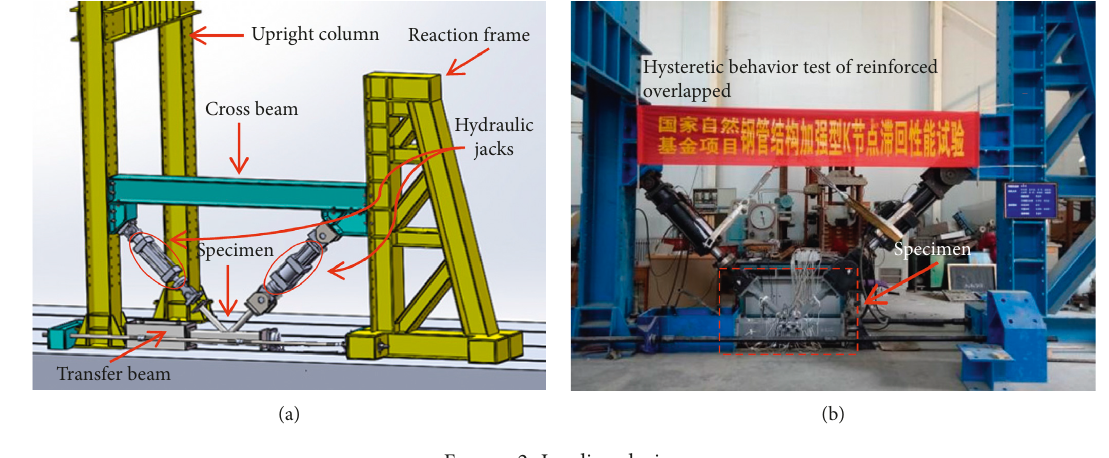
Figure 2: Loading device.